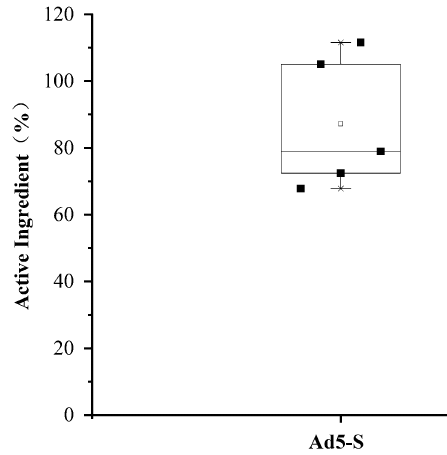
Figure 6. Ad5-S vaccine activity test